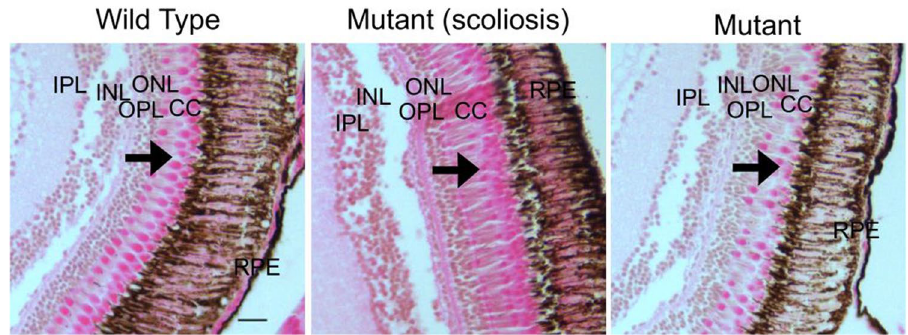
Figure 7. Hematoxylin and eosin (H&E)-stained retina of WT and mutant ttll11 adult zebrafish. Retinal histology reveals a disorganization of the cone cell layer from ttll11 mutant adult zebrafish compared to the WT (black arrows). The structure and the number of cone cells are impaired. n = 3. Scale bar 20 µ m. RPE, retinal pigmented epithelium; CC, Cone cell layer; ONL, outer nuclear layer; OPL, outer plexiform layer; INL, inner nuclear layer; IPL, inner plexiform layer; GCL, ganglion cell